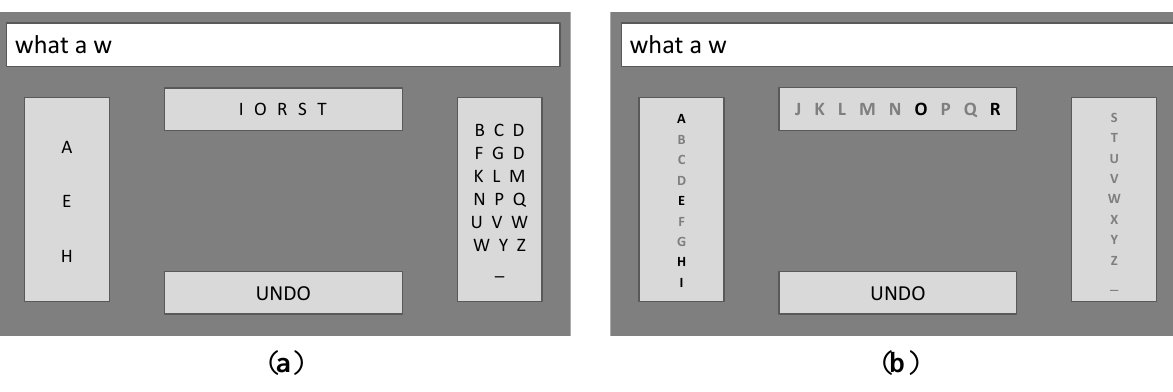
Figure 7. Dynamic ( a ) and static ( b ) interfaces for a system, that considers previously typed text ―what a w‖ for spelling the next letter. Adapted from